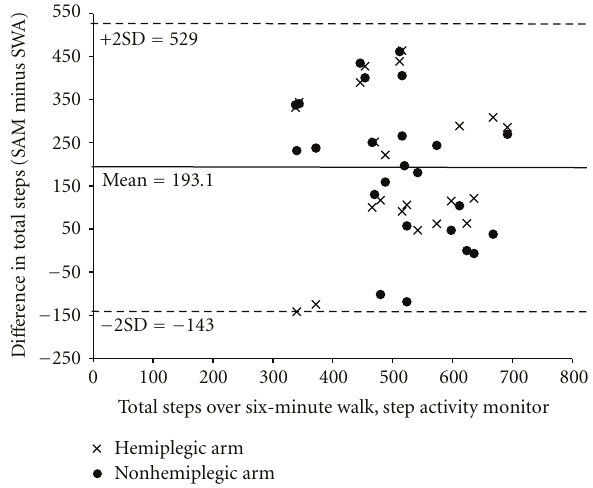
Figure 2: Graphical plot of average step count as measured by the Step Activity Monitor versus the di ff erence between the two measurement methods.